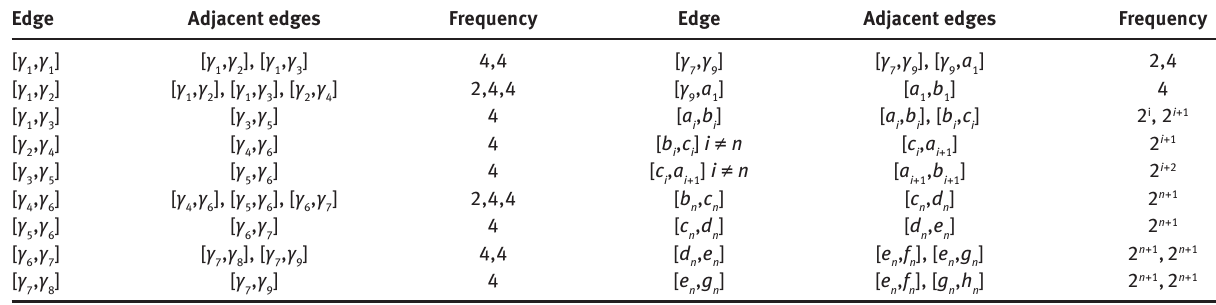
Table 9: Edge partition with respect to the pairs of end vertices of sets C and D , their corresponding adjacent edges and frequencies of occurrence for n ≥ 1.